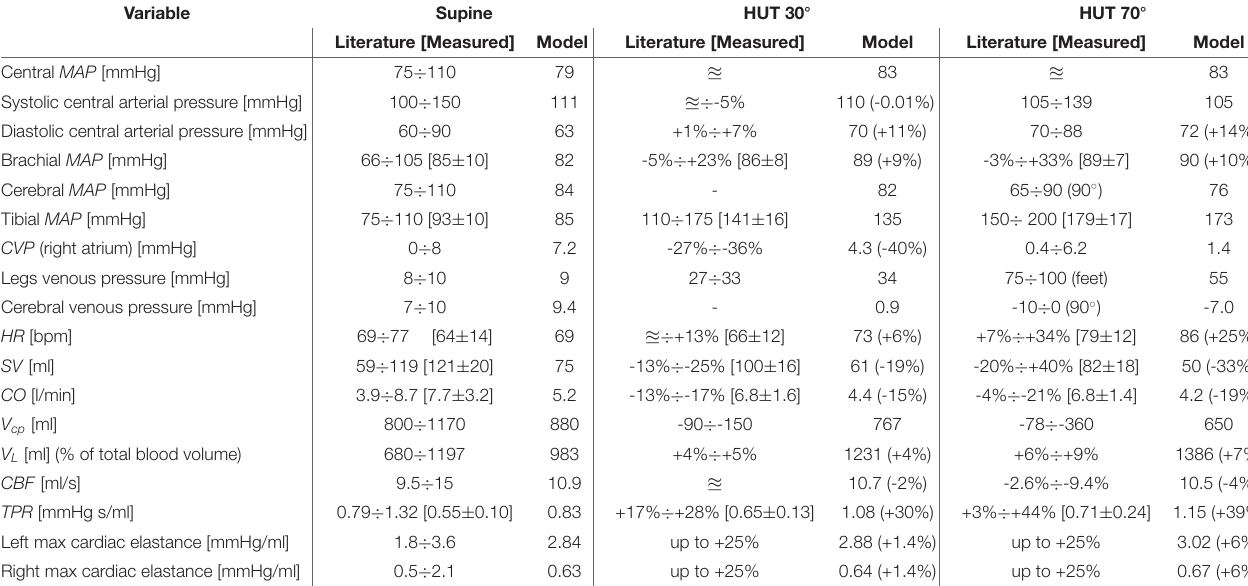
TABLE 2 | Comparison between literature data ( ≅ : no significant variation, − : no data available), our in vivo findings (in square brackets), and model outcomes for steady-state supine, HUT 30 ◦ and 70 ◦ .